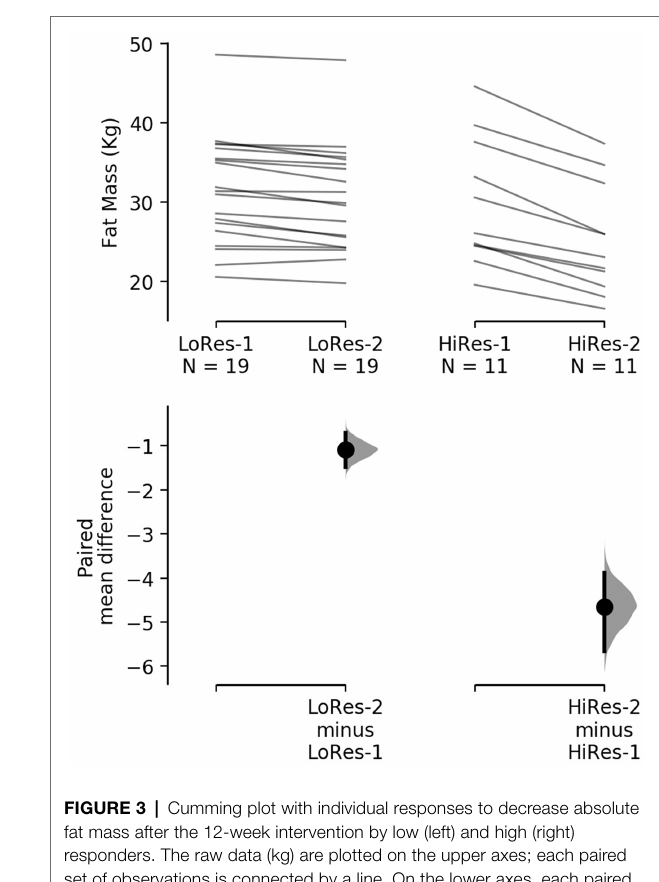
to cardiovascular variables at rest, there was a decrease of diastolic blood pressure (LoRes: 73.2